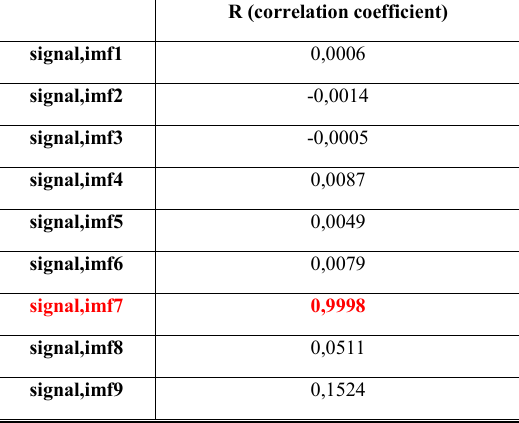
TABLE II. C ORRELATION COEFFICIENT BETWEEN SIGNAL AND IMFS R (correlation